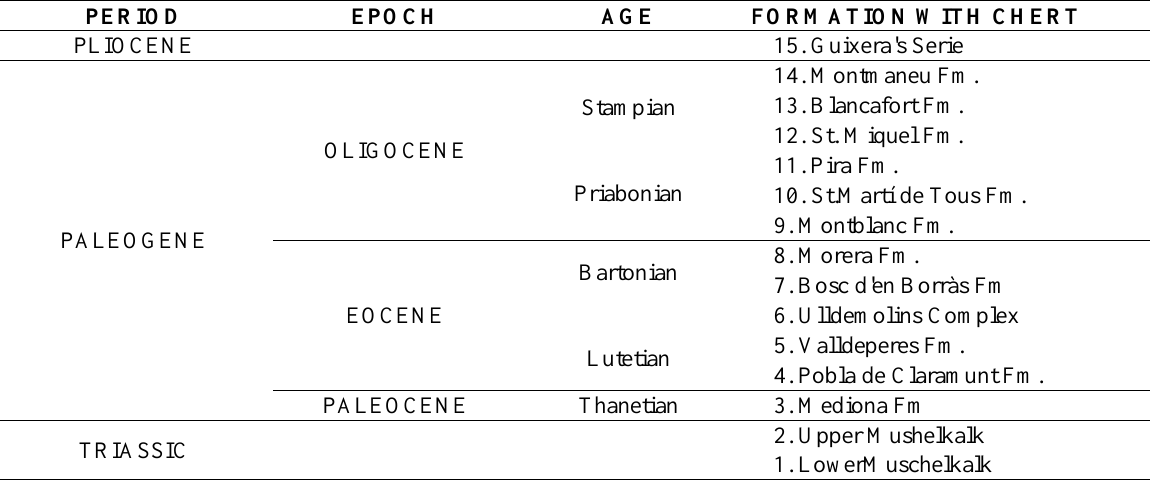
Table 1. Geological formations with chert and its geochronological